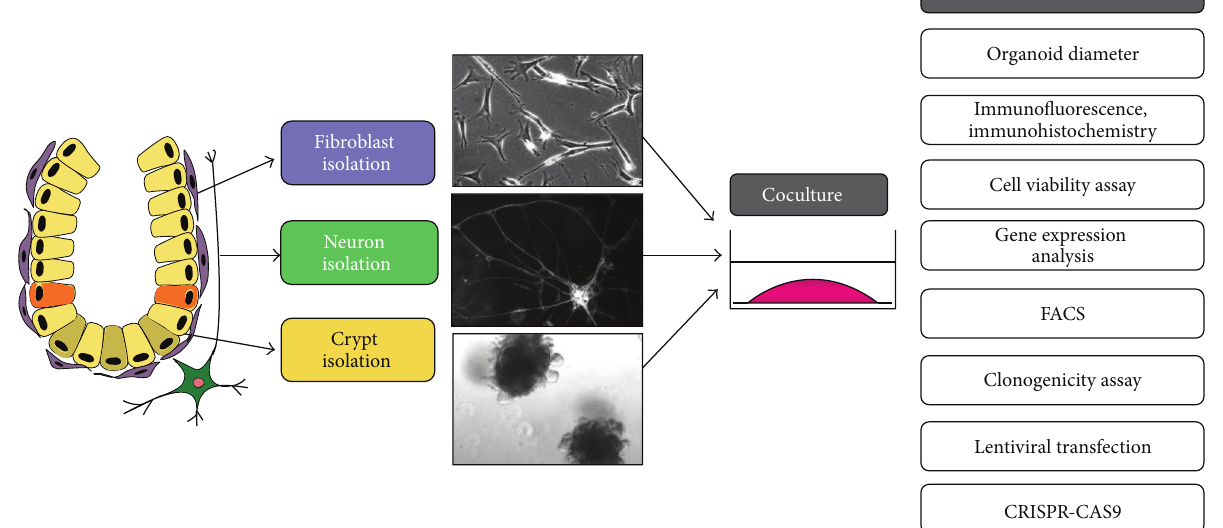
Figure 7: Reconstruction of stem cell niche in the intestine in vitro and proposed workflow. Intestinal crypts and stromal cells (neurons and/or myofibroblasts) are isolated and combined together in three-dimensional system such as organoid culture. Role of stromal cells as stem cell niche can be analyzed, for example, by the measurement of organoid diameter, cell viability assay, clonogenicity assay, gene expression analysis, and different types of staining. Identification of stem cell markers and individual cell types can be analyzed by FACS. In addition, genetic manipulations in organoids can be performed by lentiviral transfection and CRISPR-CASP9